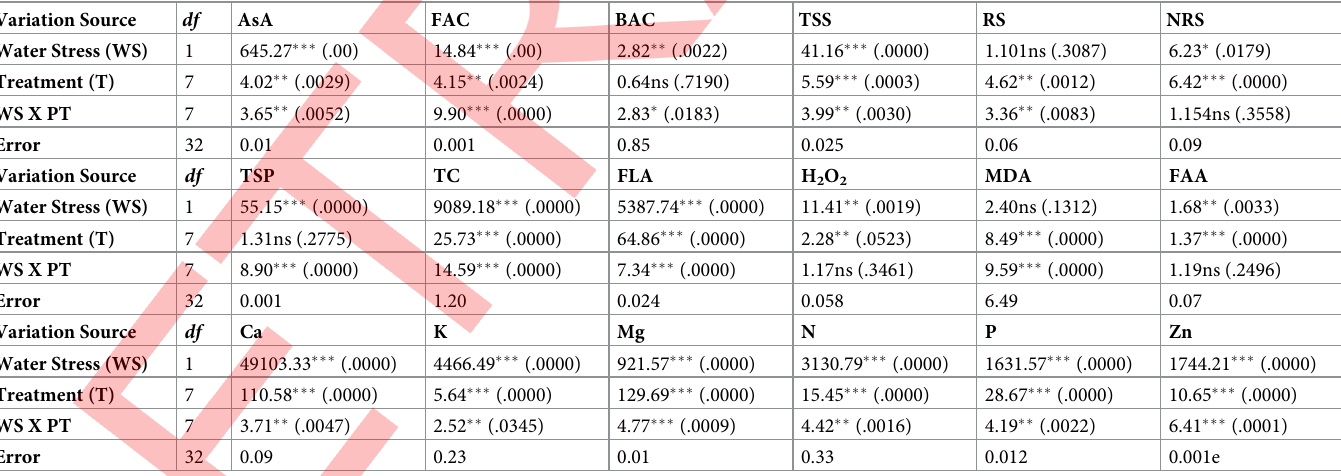
Table 2. Mean squares and p values from ANOVA of the data for physio-biochemical studies performed on water stressed maize plants treated with foliar sprinkle of ZnSO 4 and Zn-Asp and